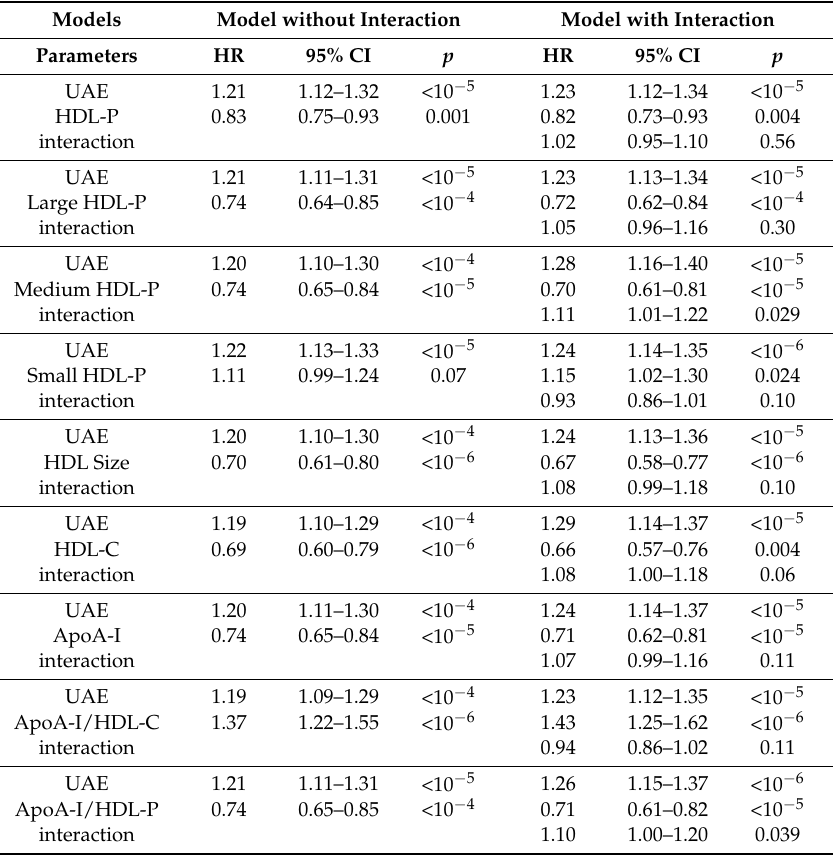
Table 5. Interaction of UAE with HDL-related parameters for second screening round as assessed by Cox proportional hazards models of cardiovascular event occurrence adjusted for gender and age. Hazard ratios are per SD unit for all